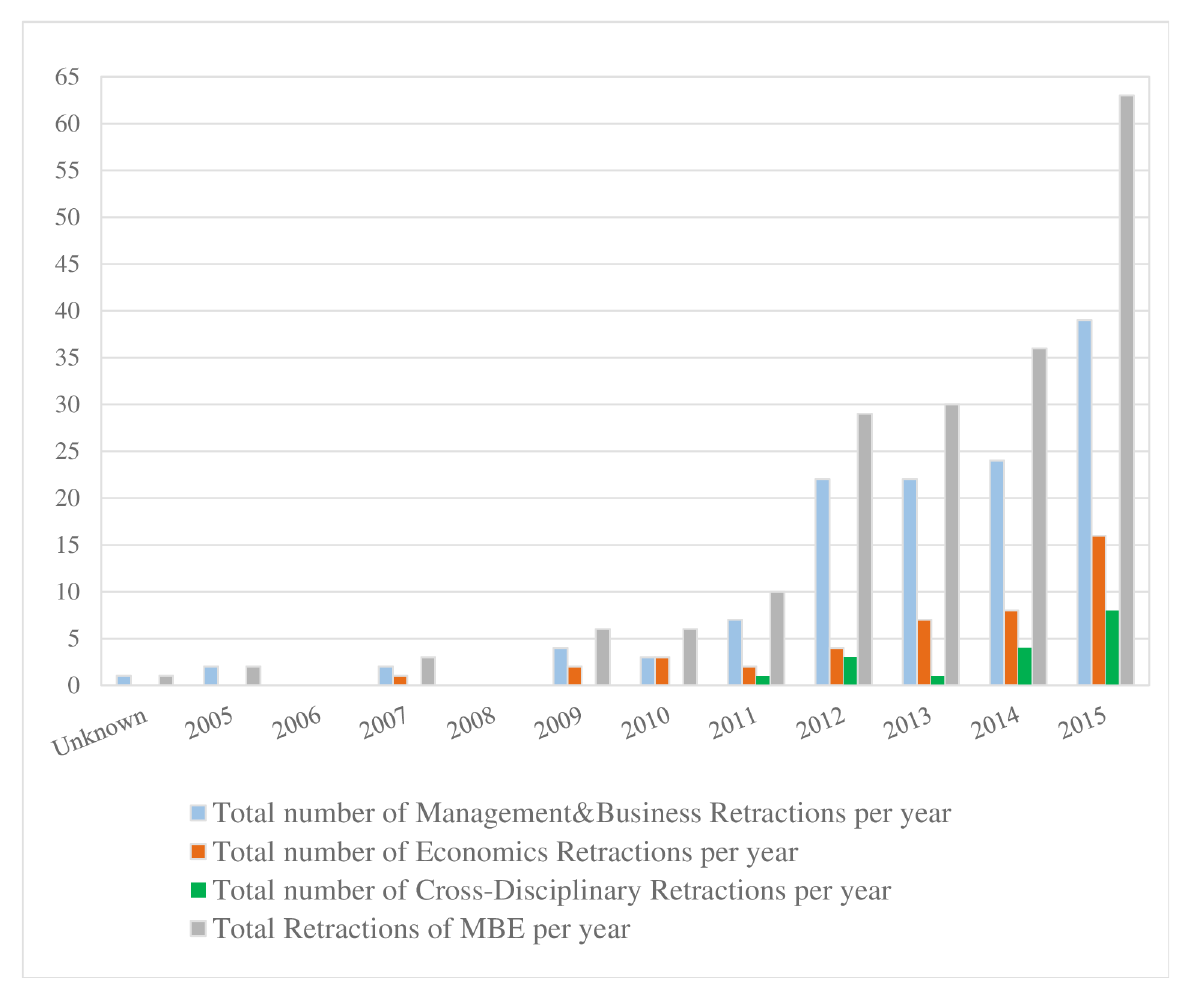
Fig 1. Total Numbers of Retractions in Management/Business and Economics from first documented retraction until the end of 2015. (One retracted paper was published in 2001, but retraction year is unknown.) Sources: Authors calculation based on keyword searches in seven